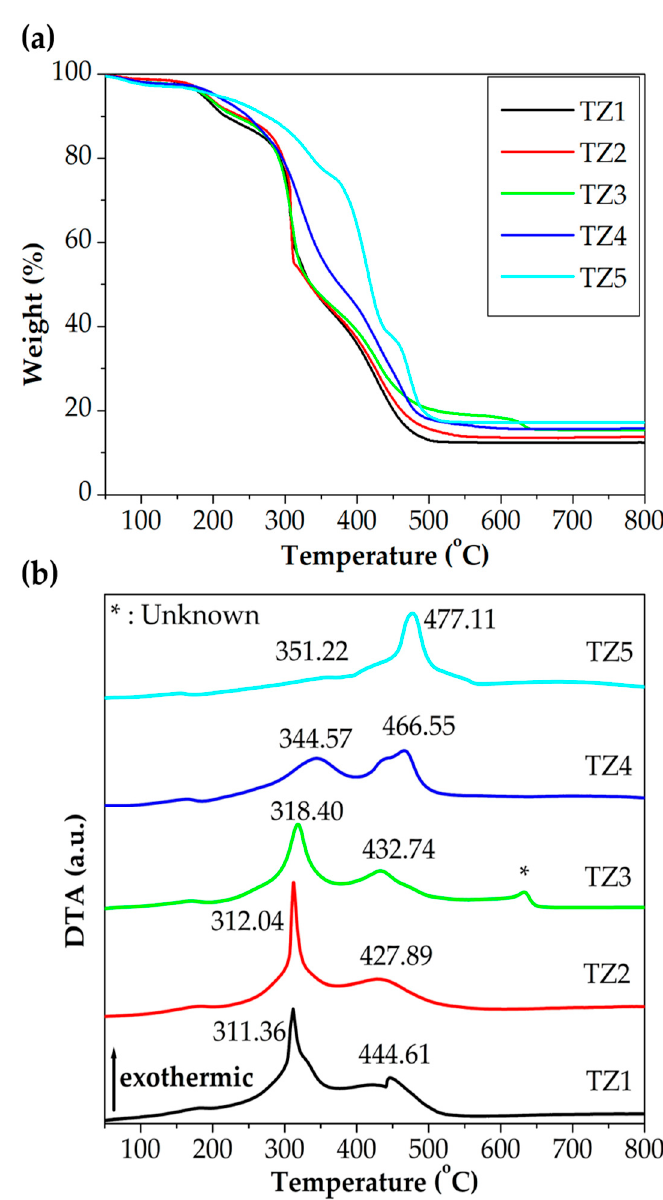
Figure 2. ( a ) Thermogravimetric analysis (TGA) and ( b ) differential thermal analysis (DTA) curves of as-spun Ti–Zn complex oxide nanofibers with different molar ratios of Ti and Zn in an air atmosphere (TZ1: 10:0, TZ2: 9:1, TZ3: 5:5, TZ4: 1:9 and TZ5: 0:10).